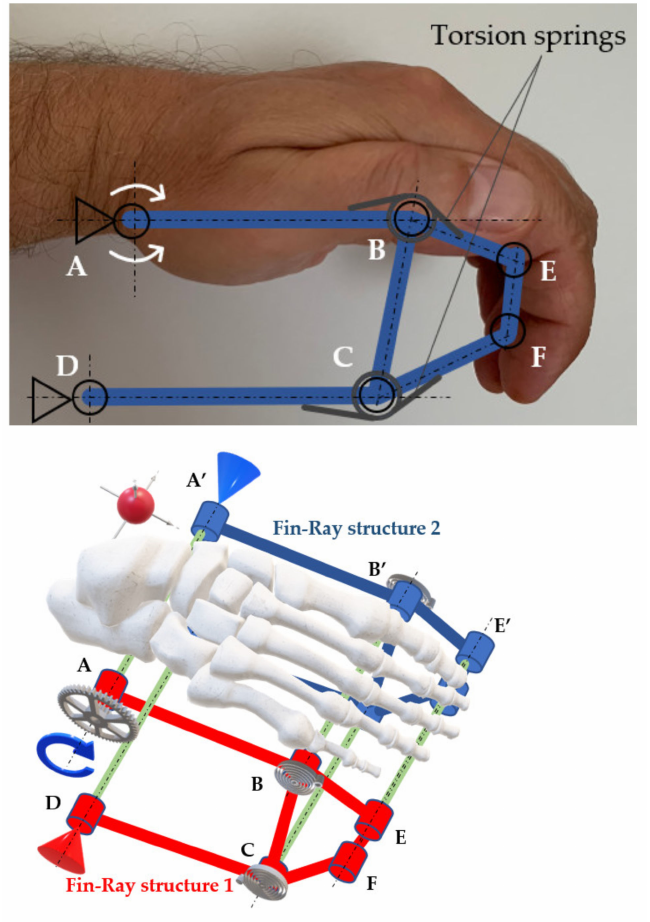
Figure 6. Diagram of principle of the hand support based on the Fin-Ray effect.